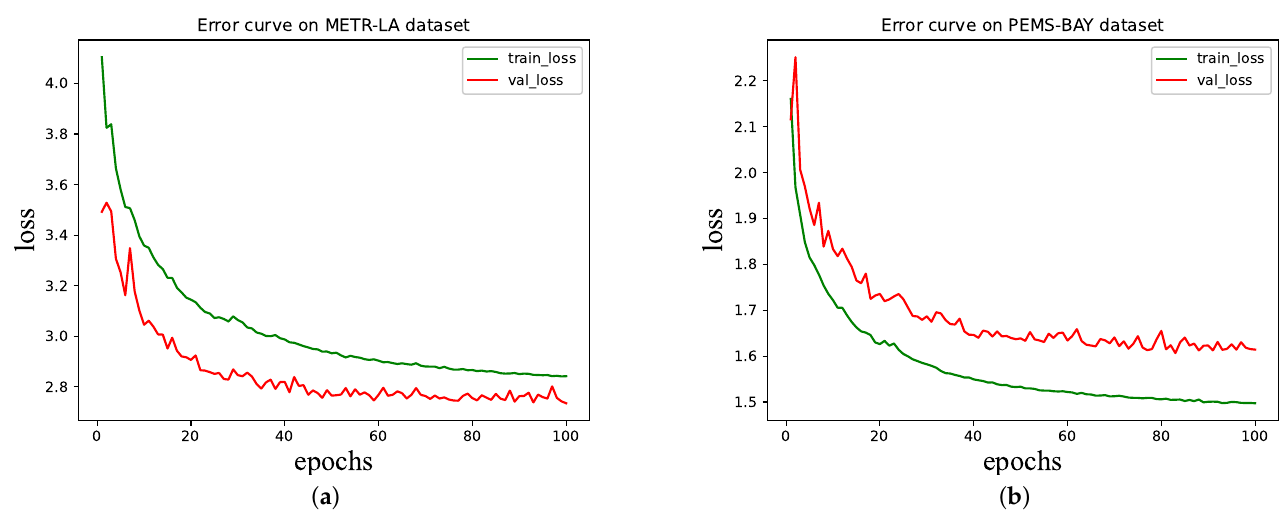
Figure 5. Convergence curves of training and validation errors on the two datasets: ( a ) the conver- gence curves of training and validation errors on the METR-LA dataset; ( b ) the convergence curves of training and validation errors on the PEMS-BAY